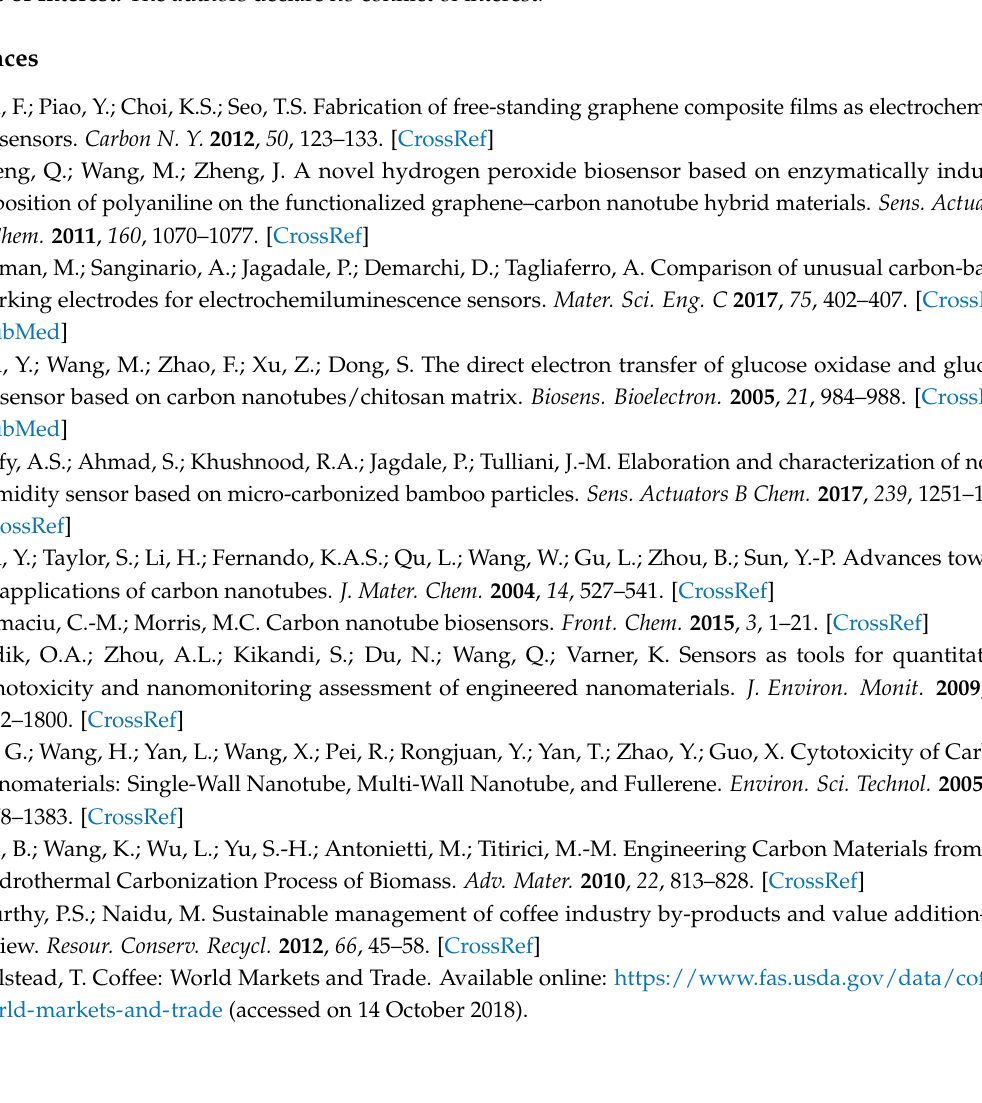
Figure S1: Particle size distribution of CGB powder after 5 min of sonication in